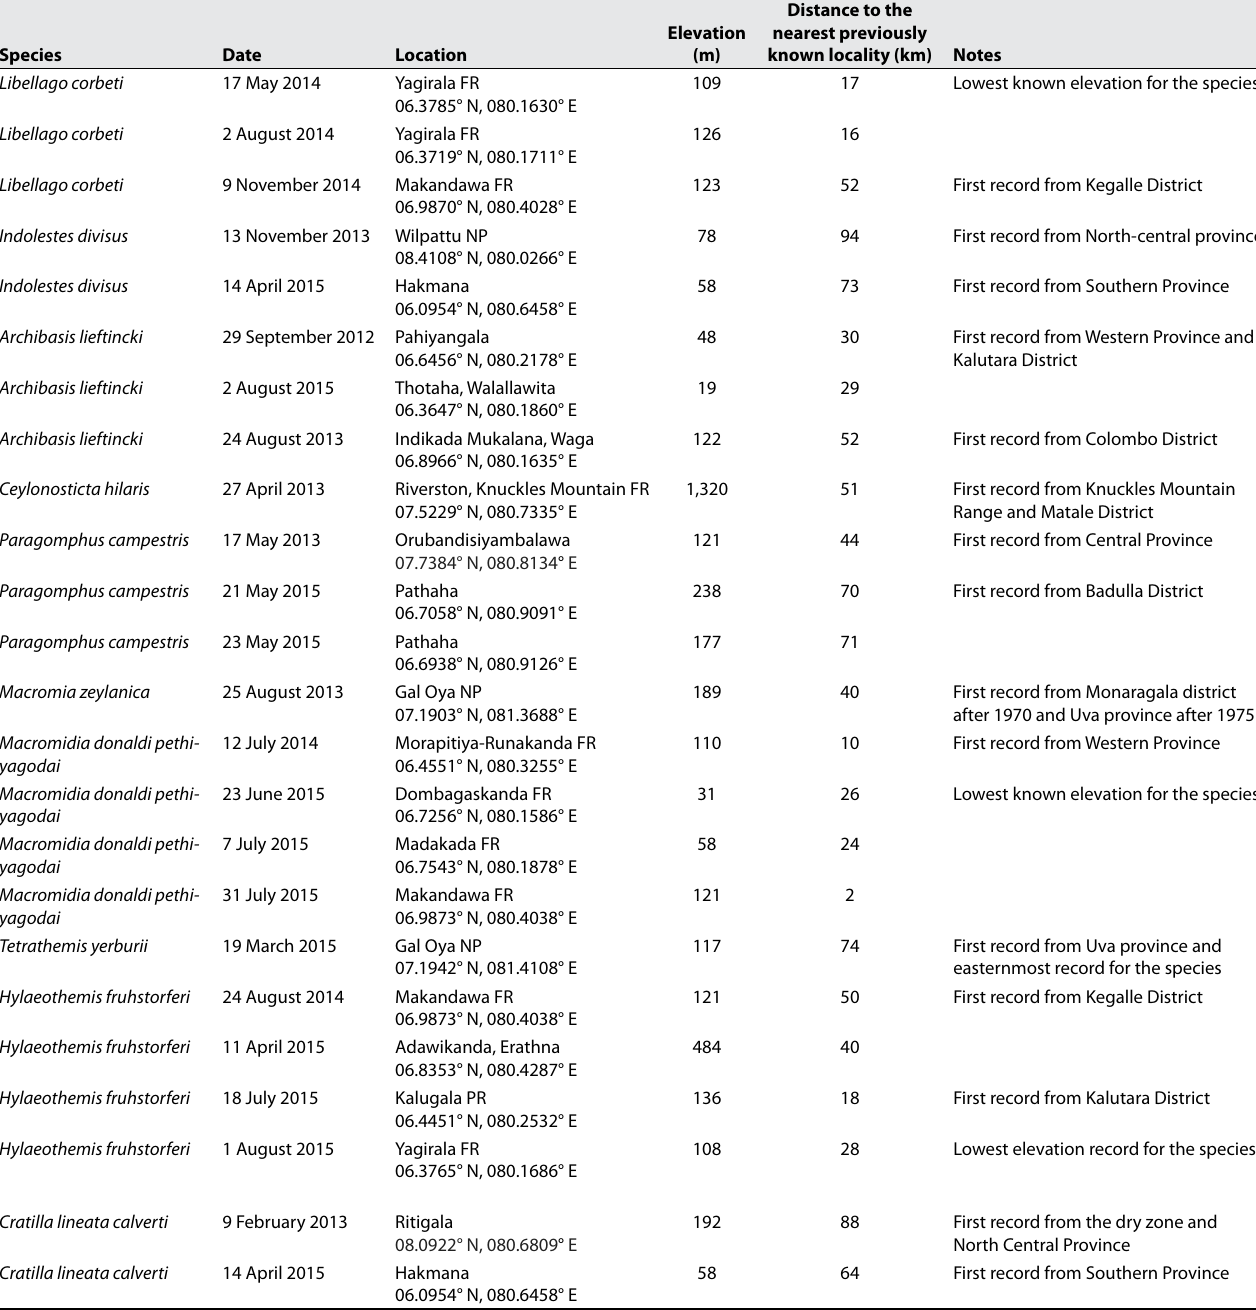
Table 1. Observations on the Odonata species recorded (FR=Forest Reserve, NP=National Park, PR=Proposed Reserve).